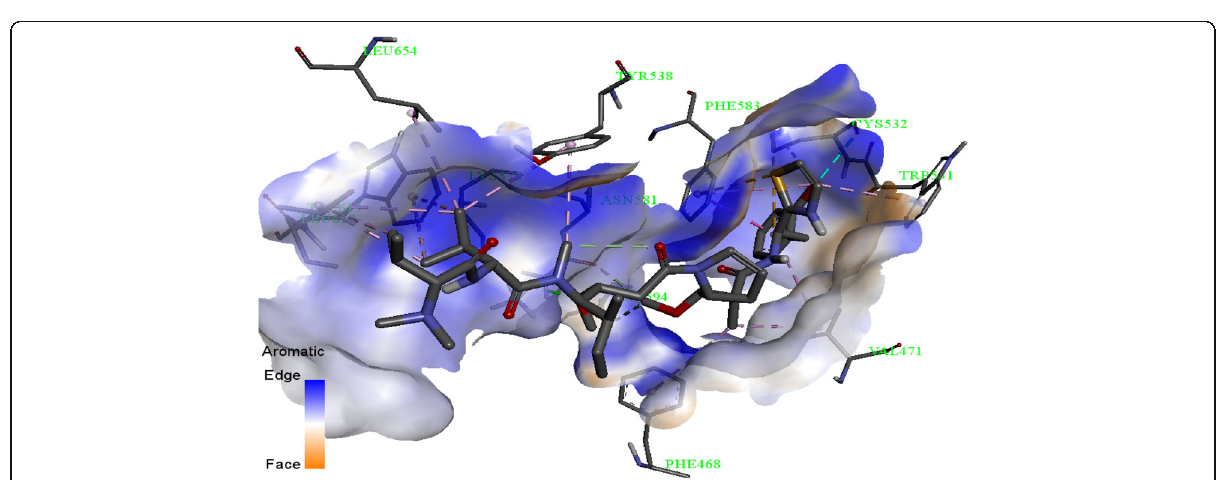
Fig. 5 3D diagram of the interaction between N1 with